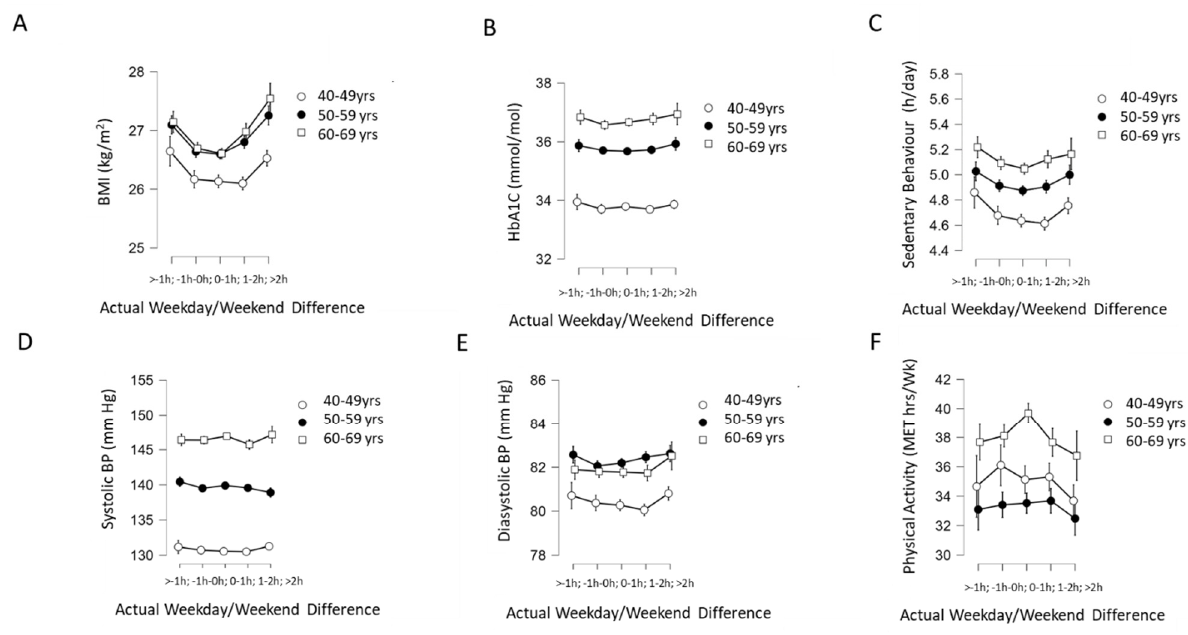
Figure 7. Interaction of actual WD/WE (categorized into five groups: > − 1 h, − 1 h to 0 h; 0 h to 1 h; 1 h to 2 h; >2 h) with age (in three groups: 40–49 years old, 50–59 years old and 60–69 years old) on ( A ) BMI, ( B ) HbA1c, ( C ) sedentary behaviour, ( D ) systolic blood pressure, ( E ) diastolic blood pressure and ( F ) physical activity expressed in metabolic equivalent of energy (MET) hours per week. For all dependent variables, there were no statistically significant interactions detected between WD/WE and age group. Error bars (where visible) indicate 95% confidence